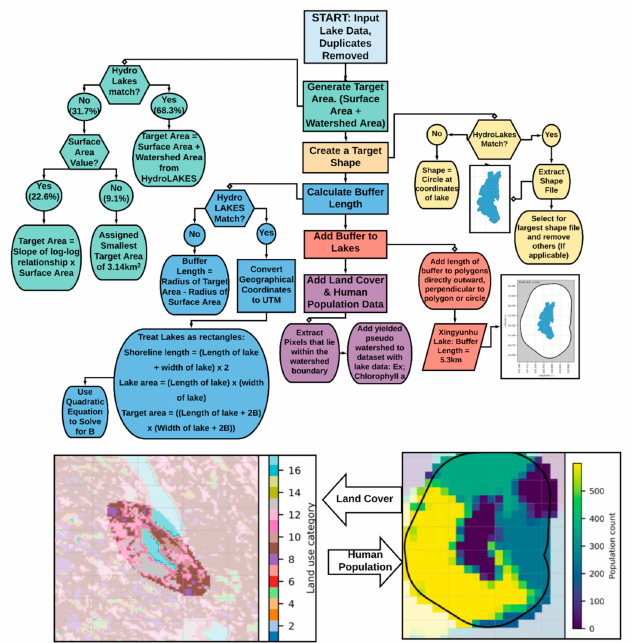
Figure 1. Flowchart for pseudo-watershed Analytical Framework indicating the methods of developing the pseudo-watersheds for the 9313 included in the analysis. Black-pointed arrows indicate the direction of the process. White-diamonded arrows indicate additional information and